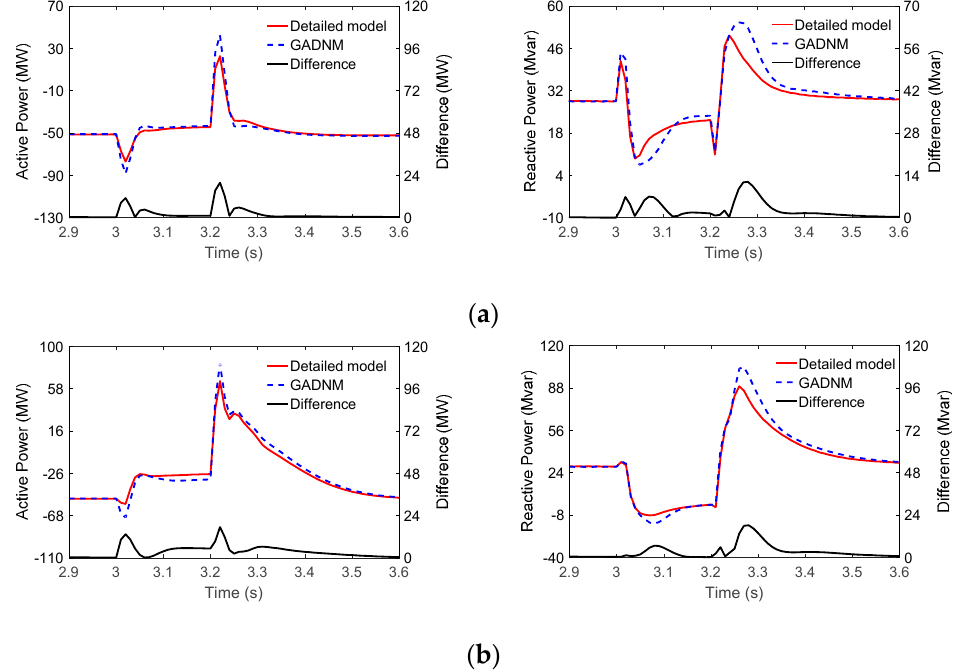
= 200%. ( a ) 20% U n voltage dip.